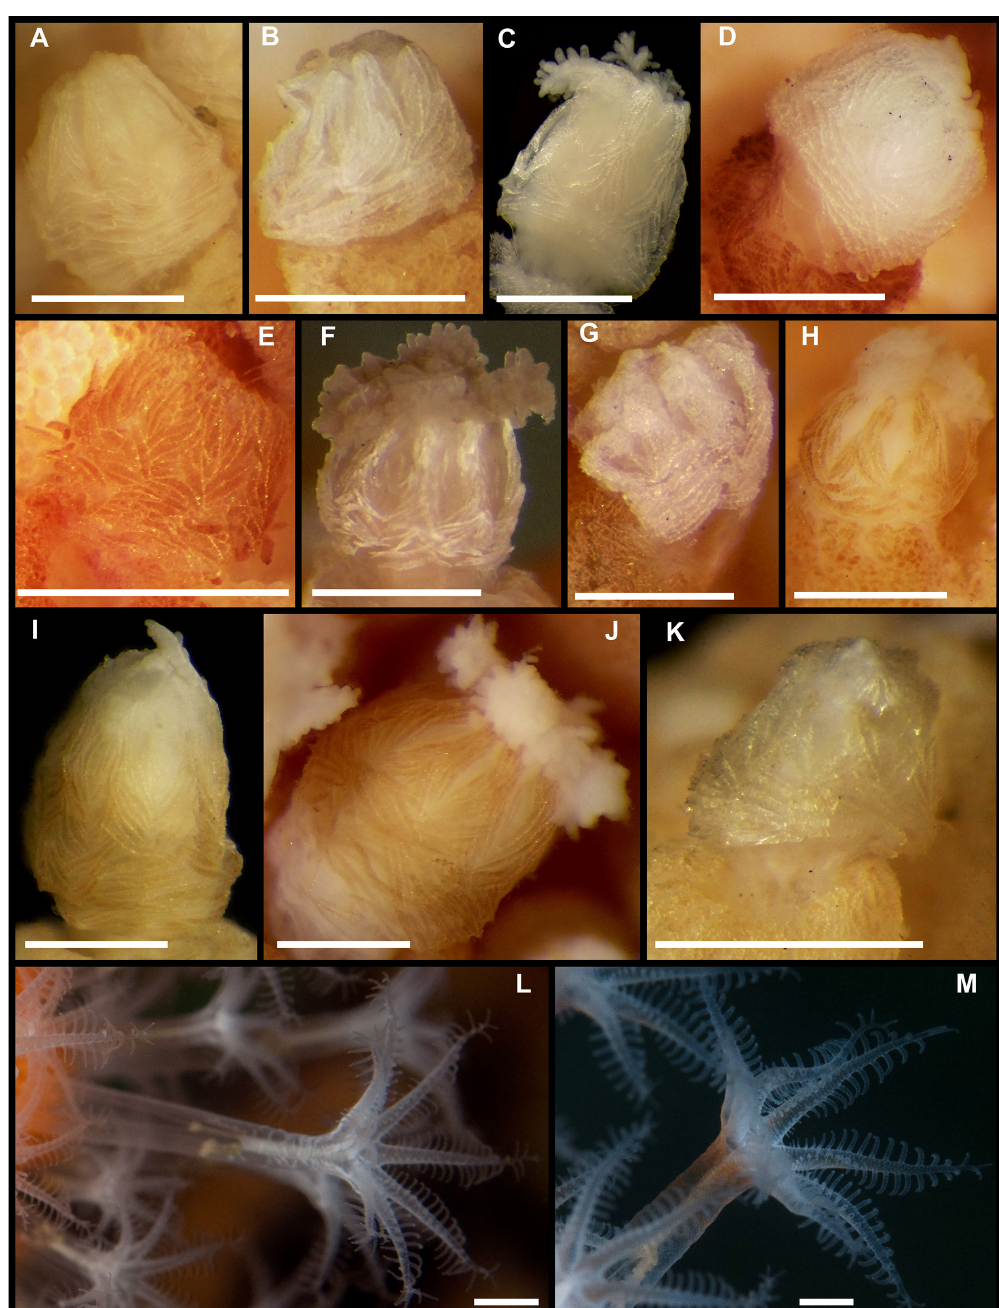
Fig. 2. Polyps. A . Kotatea amicispongia gen. et sp. nov., holotype (NIWA 156312). B . K. aurantiaca gen. et comb. nov. (NIWA 75330). C . K. kapotaiora gen. et sp. nov., holotype (NIWA 3974). D . K. kurakootingotingo gen. et sp. nov., holotype (NIWA 101538). E . K. kurakootingotingo gen. et sp. nov., paratype, small polyp with coloured collaret and points (MAGNT C015221). F . K. lobata gen. et sp. nov., holotype (NIWA 101313). G . K. niwa gen. et sp. nov., holotype (MAGNT C015226). H . K. raekura gen. et sp. nov., holotype (NIWA 101537). I . Ushanaia ferruginea gen. et sp. nov., holotype (NIWA 156313). J . U. fervens gen. et sp. nov., holotype (NIWA 156311). K . U. solida gen. et sp. nov., holotype (NIWA 102133). L . K. aurantiaca gen. et comb. nov., in situ (uncollected specimen), Poor Knights Islands, photo by Ian Skipworth (ianskipworth.com). M . U. fervens gen. et sp. nov., in situ (uncollected specimen), Fiordland, photo by Shane Geange. Scale bars = ~1